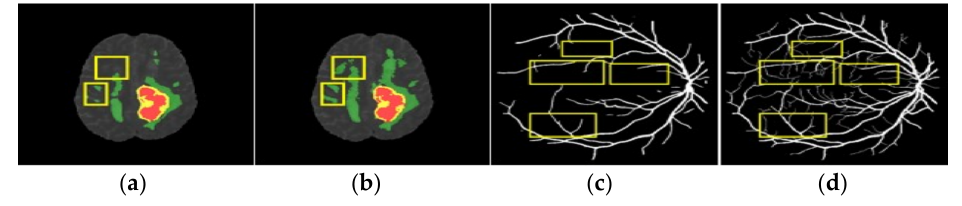
Figure 1. Medical image segmentation. ( a ) At-Unet; ( b ) Brain tumor ground truth; ( c ) AC-Loss; ( d ) Retinal ground truth, where the yellow boxes indicate the regions where the methods are mis-segmented compared to ground truth.